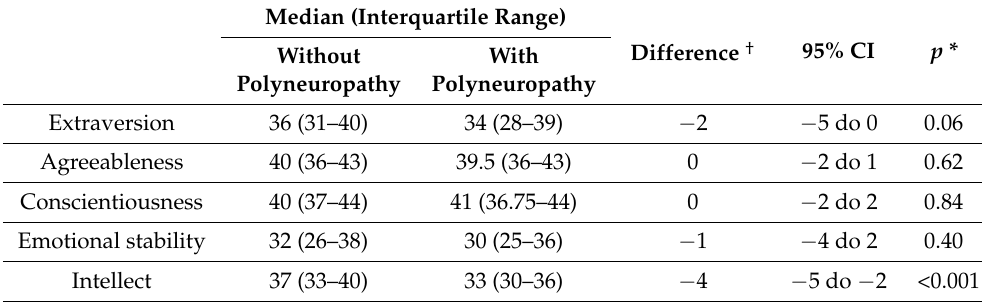
Table 12. Differences in personality dimensions relating to the occurrence of polyneuropathy. Median (Interquartile Range)